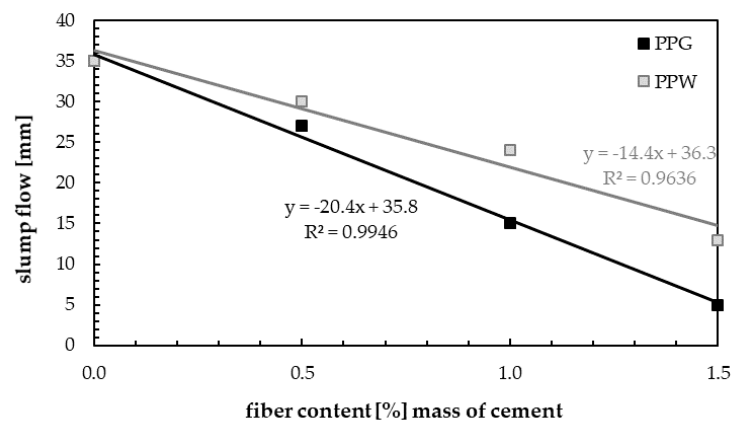
Figure 10. Slump test results.